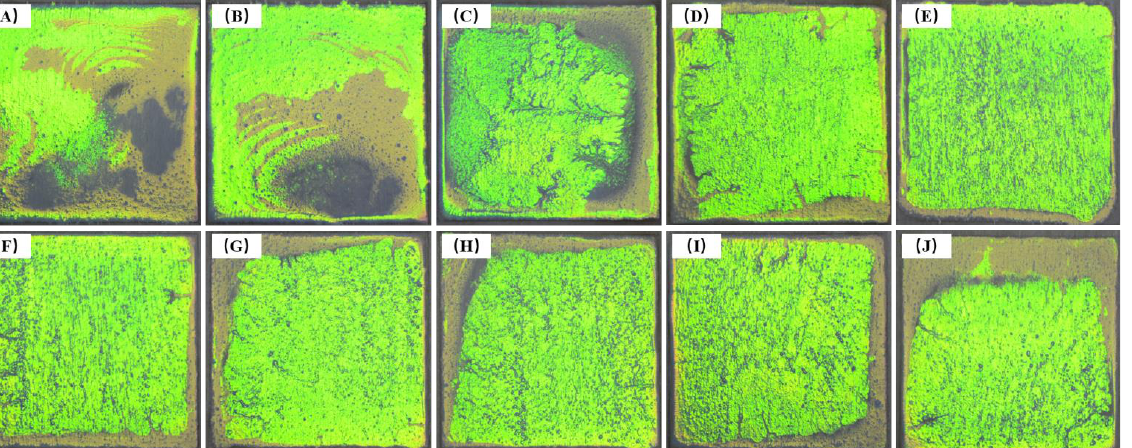
Figure 17. Photos of photonic crystals formed by the self-assembly of P(St-AA) colloidal microspheres at different temperatures: ( A ) 10 °C; ( B ) 20 °C; ( C ) 30 °C; ( D ) 40 °C; ( E ) 50 °C; ( F ) 60 °C; ( G ) 70 °C; ( H ) 80 °C; ( I ) 90 °C; ( J ) 100 °C.